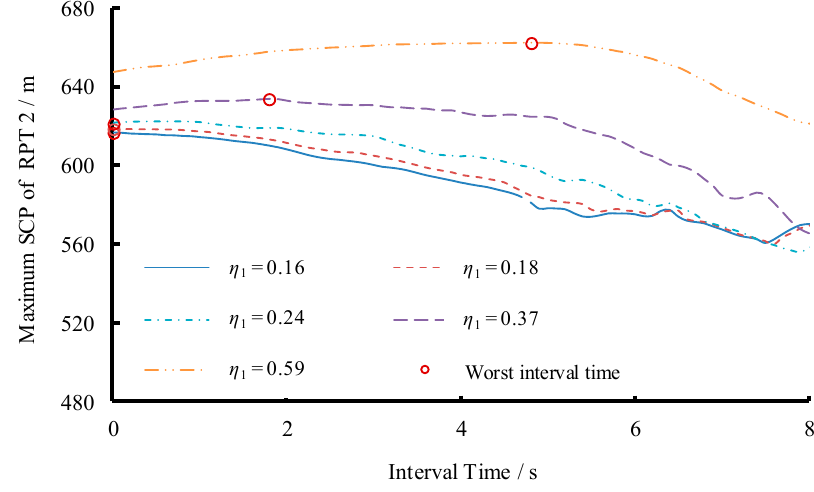
Figure 13. Maximum SCP with different time intervals of different η 1 for Scenario 2.